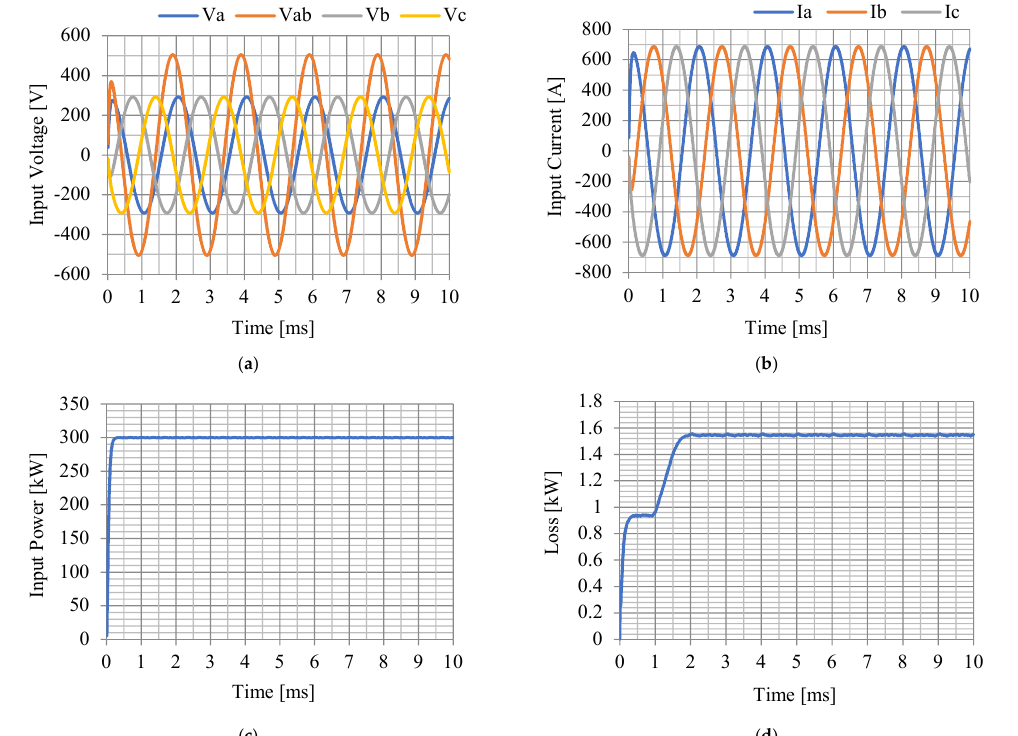
Figure 13. Characteristics at 30 krpm (300 kW power generation state): ( a ) Output voltage. ( b ) Output current. ( c ) Output power. ( d ) Loss.